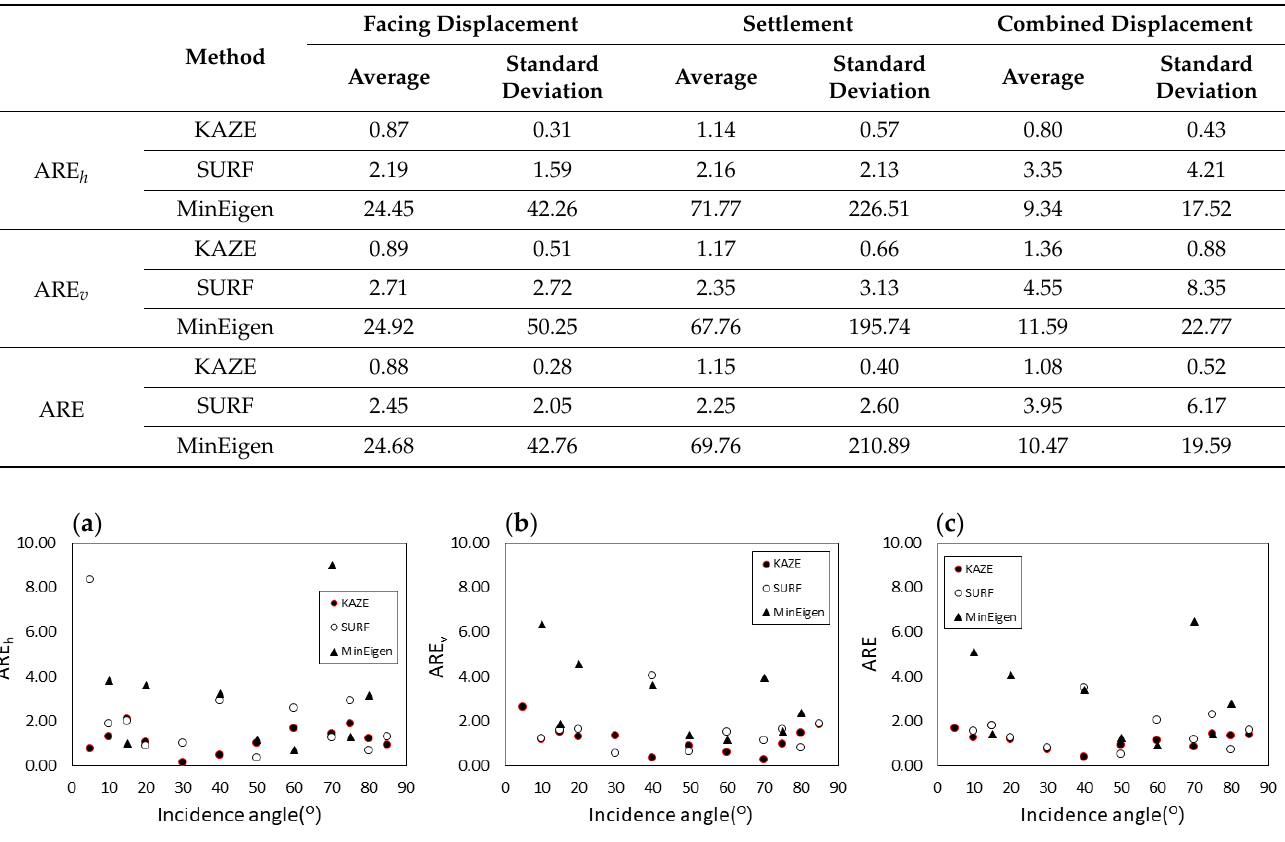
Figure 10 . Distribution of ARE h , ARE v , and ARE with different feature matching methods at com- bined displacement. ( a ) ARE h ; ( b ) ARE v ; ( c ) ARE. 4.2. Multiblock Experiment Figure 11 presents an example of images of the same size (800 × 640 pixels) for the multiblock experiment and graffiti images taken from well-known datasets from the Uni- versity of Oxford [44]. In addition, 3138 and 8638 features were extracted from the labor- atory experiment images and graffiti images, respectively. In the laboratory experiment images, relatively fewer features were detected because the facing of blocks was smooth and simple. Specific patterns (edges, corners, and blobs) were not included in the multi- block structure in which blocks with low-feature-intensity variation were repeatedly ar-